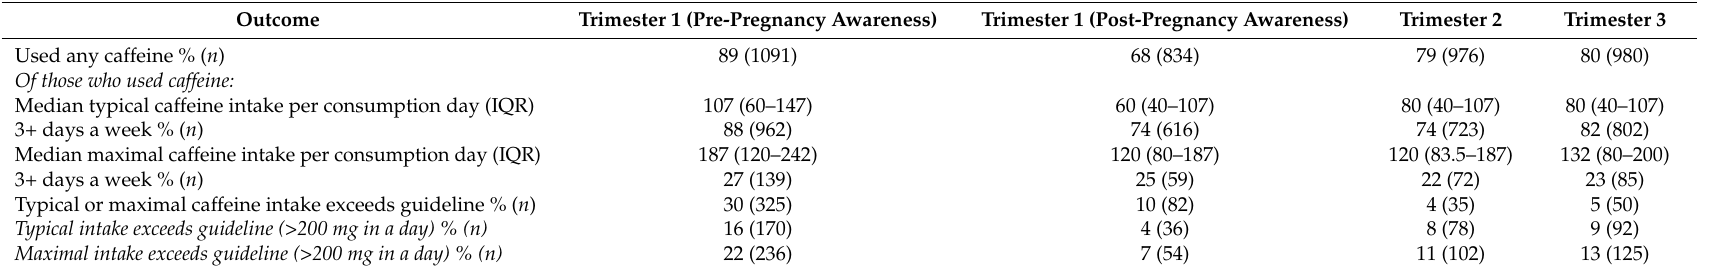
Table 1. Patterns of caffeine use pre- and post-pregnancy awareness ( n = 1232).